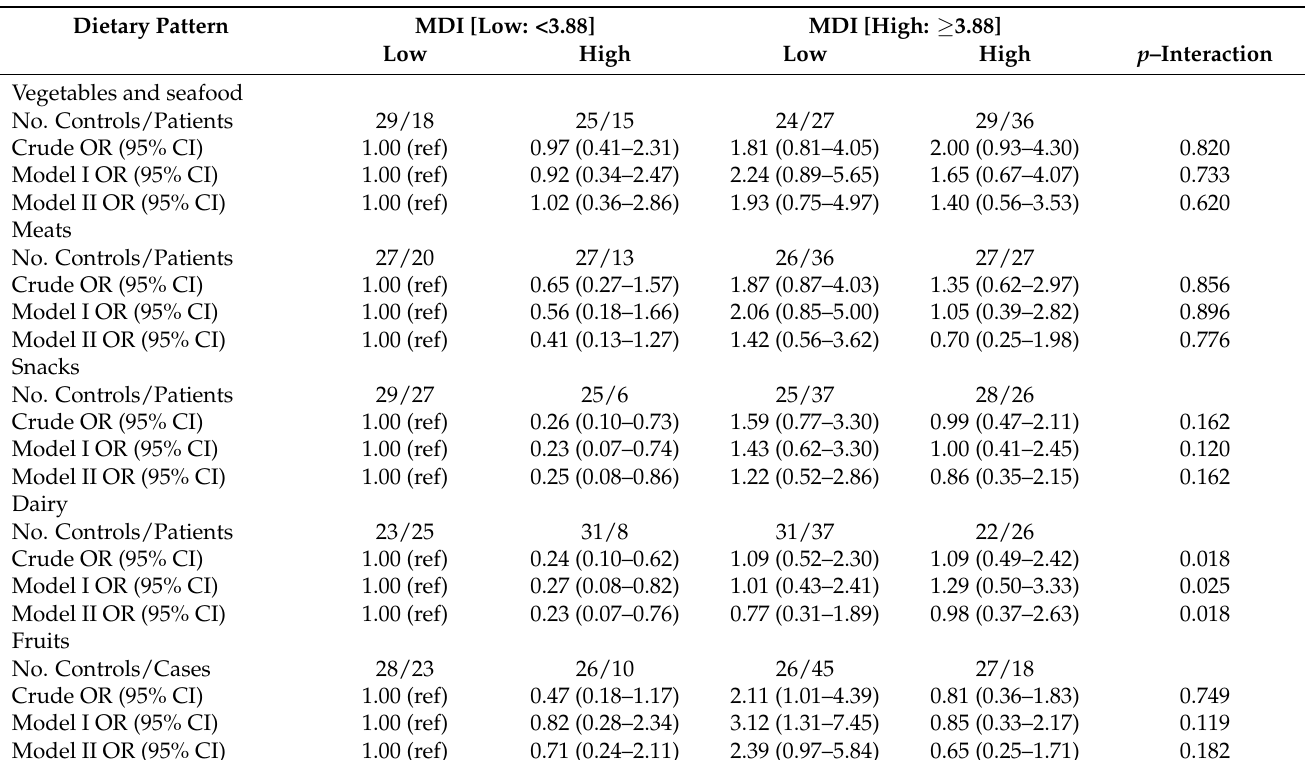
Table 6. Combined effect of dietary patterns and MDI on the GC risk in